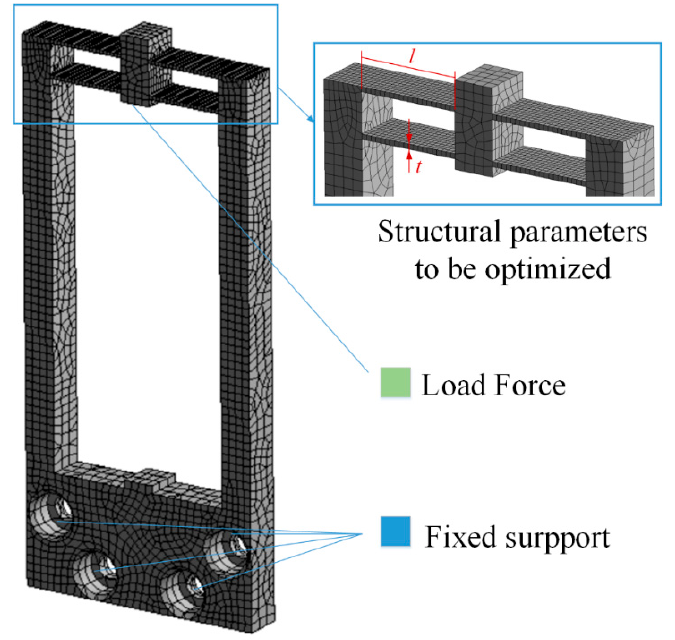
Figure 5. Mesh and load of the model.